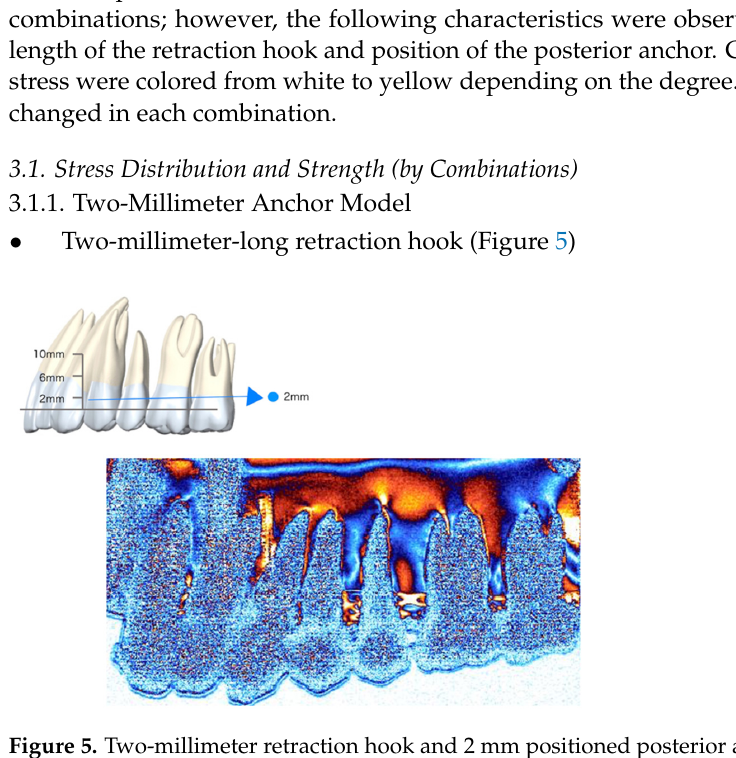
Figure 6. Six-millimeter retraction hook and 2 mm positioned posterior anchor model. • Ten-millimeter-long retraction hook (Figure 7) (a) Apical region Conversely to the 2 mm and 6 mm retraction hook sets, compressive stress vanished, and the tensile stress appeared in the apical region from the canine to the second molar. Additionally, compressive stress was detected at the apex of the central incisor; (b) Center region Tensile stress was extended to the inter root space at the second premolar to the second molar at the center region; (c) Cervical region